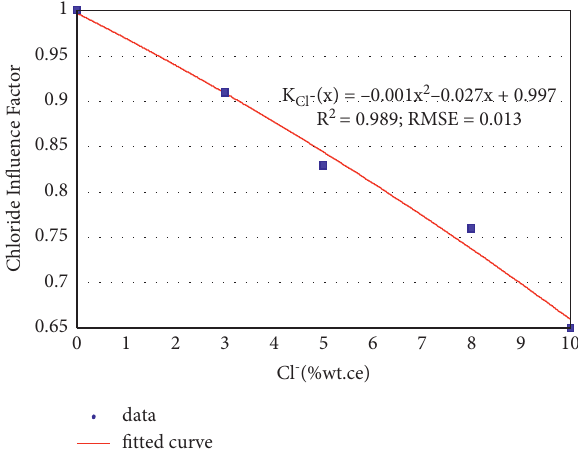
Figure 17: Chloride influence factor on electric resistance relationship.